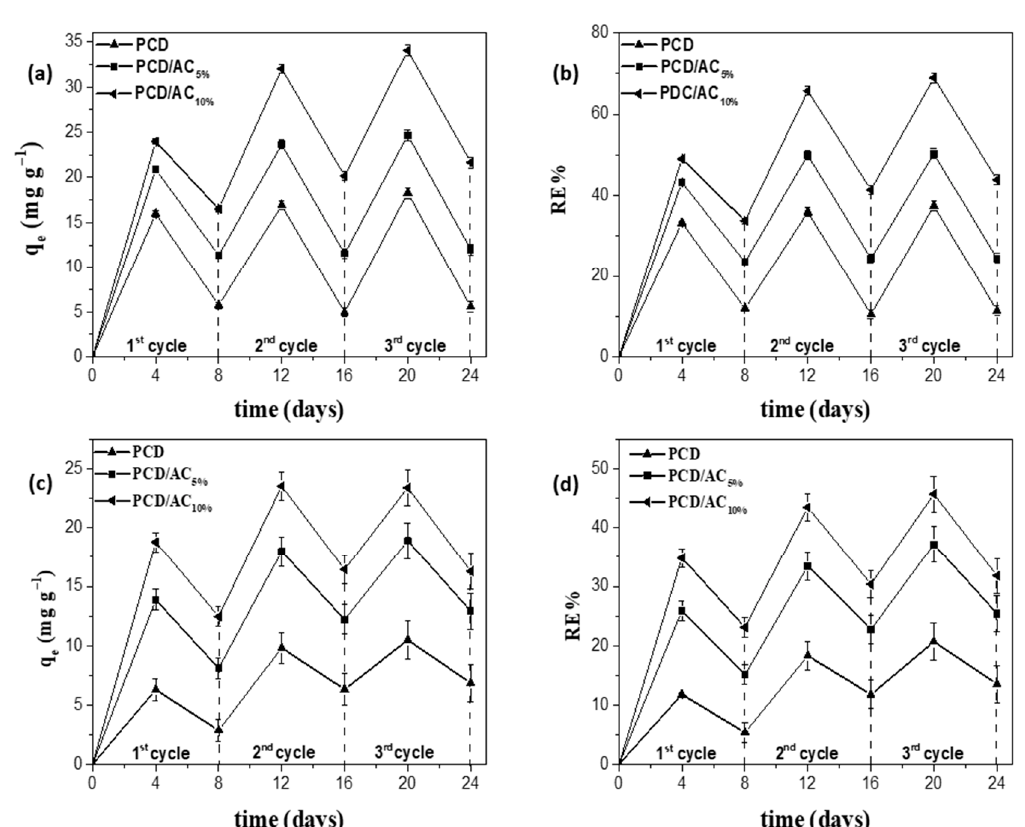
Figure 8. Graphical representation of q e ( a ) and RE% ( b ) values for IMD and q e ( c ) and RE% ( d ) values for CYM on three cycles of sorption/desorption.